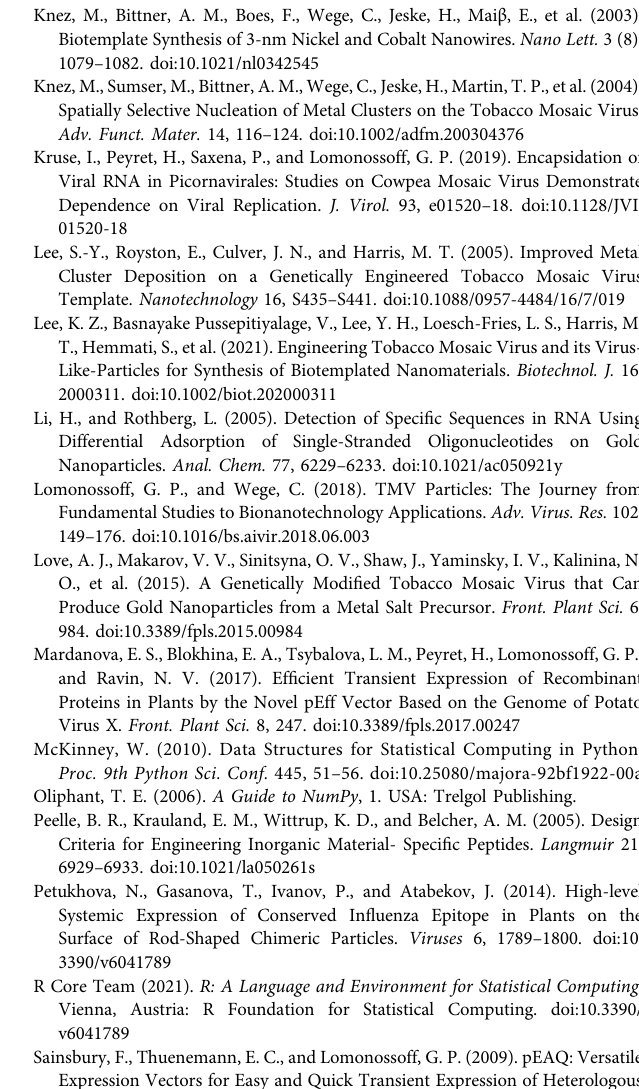
Supplementary Figure S1 | Measurement of nanorods. (A) Transmission electron microscopy image of CP/OAS nanorods. Left panel UA-stained image. Clustered nanorods incorrectly acknowledge to be nanorods, red arrows and nanorods not recognised, blue arrows. Right panel numbered nanorods identi fi ed by computational analysis. (B) Distribution of all measured nanorods, upper panel. Lower panelmeasured distributioncorrectedwithremoval ofincorrectlyidenti fi edor roguenanorods. (C) Variationofmeasurednanorodlengthsbetweeneightindividual GridSquares of CP/OAS, gradient fraction 13, Figure 3A . Measurements were madeofparticlesisolatedfrompEff-CP/OASin fi ltratedleaves.Yaxes,measurement length in nm; X axes, length distribution in 5 nm increments. The descriptive statistics for each GridSquare is presented. Supplementary Figure S2 | NuPAGE-MOPS gel electrophoresis of the various nanorods at the different stages of isolation. Supplementary Figure S3 | Colloidal gold nanoparticles binding on CP/OAS-A8 nanorods was measured by transmission electron microscope. Scale bars as shown. Supplementary Figure S4 | Control experiments for colloidal gold nanoparticles binding on (A) CP/OAS and (B) wt TMV was measured by transmission electron microscope images respectively. Scale bars as